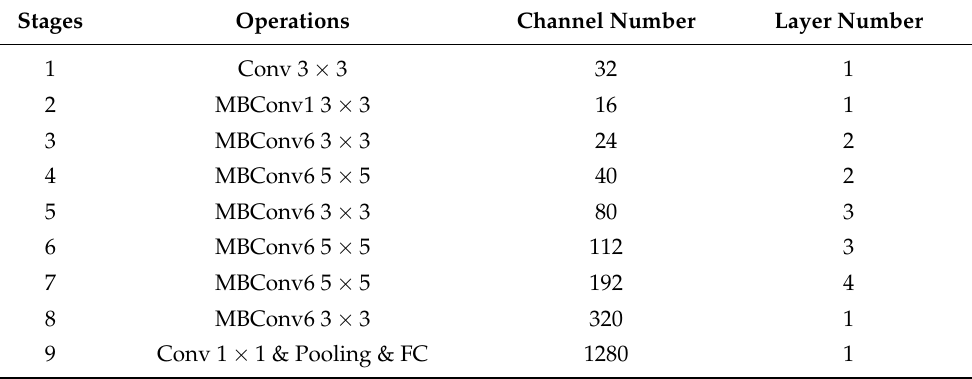
Table 1. Network architecture of EfficientNet